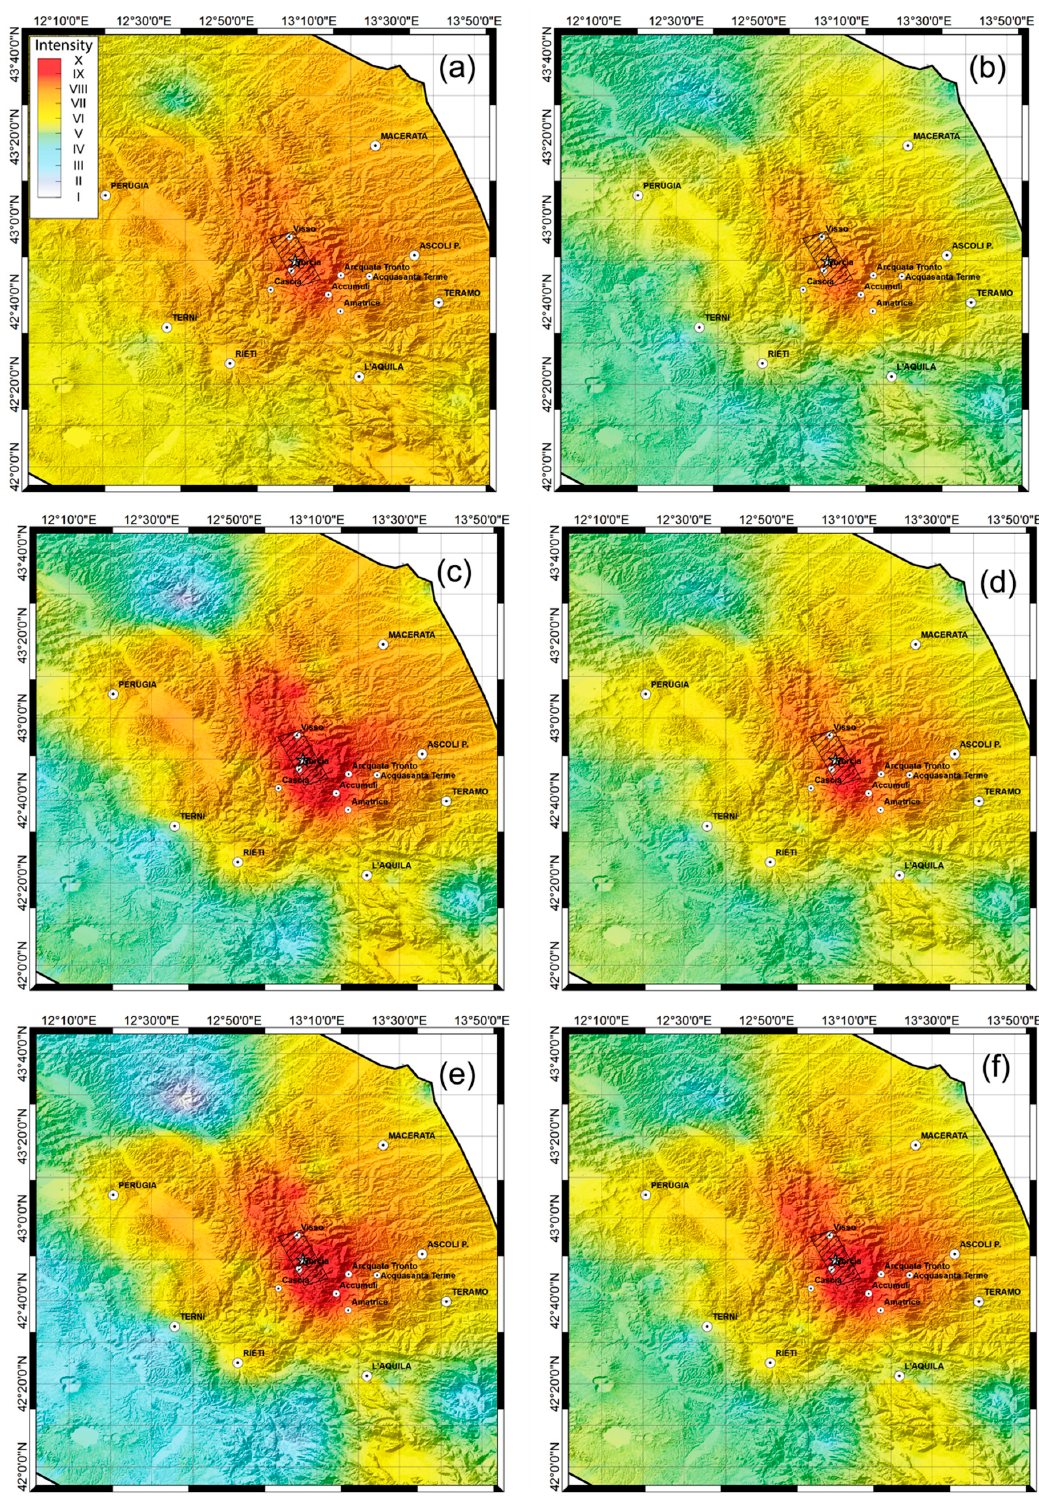
Figure 9. Intensity maps for the M W 6.5 Norcia earthquake based on cumulative absolute velocity ( a , c , e ) and Arias intensity ( b , d , f ). The maps were obtained by three different models: Cabanas et al. [27] ( a , b ), Koliopulos et al. [28] ( c , d ), and Tselentis and Danciu (2008) [29] ( e , f ).